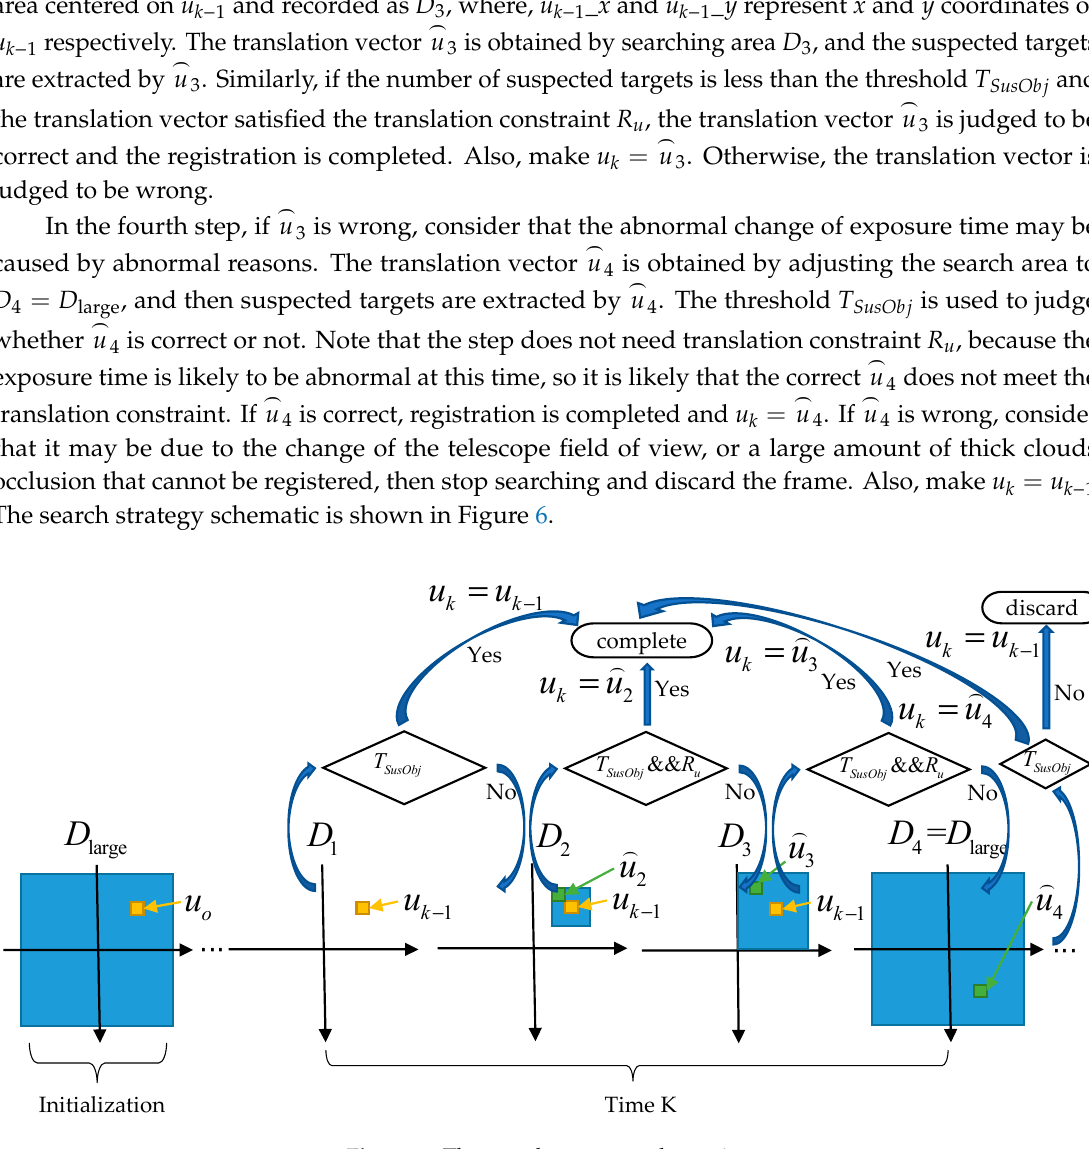
Figure 6. The search strategy schematic.